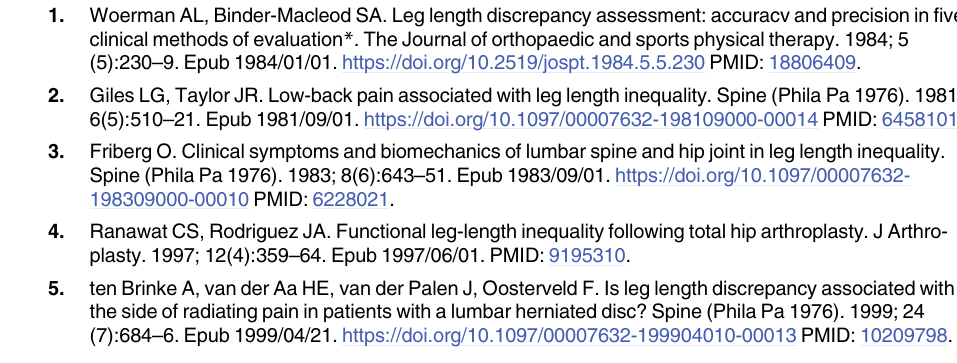
S1 Table. Data underlying rasterstereographic measurements on patients and control